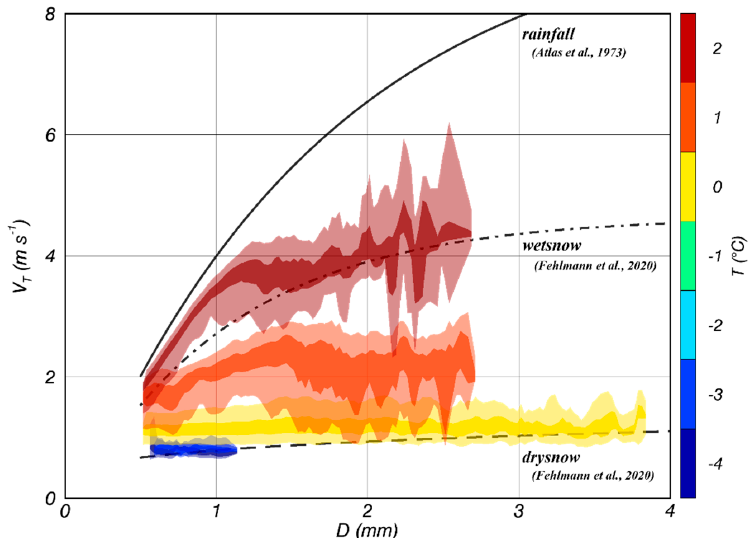
Figure 5. Color − shaded 2D histogram plots of V T versus D for each T class. The color shades correspond to the data range of ± 10% and ± 25% from the median value. The black long − and dot − dashed lines denote the V T values for snow and melted snow, respectively [50]. The black solid line represents V T , as suggested in [51].